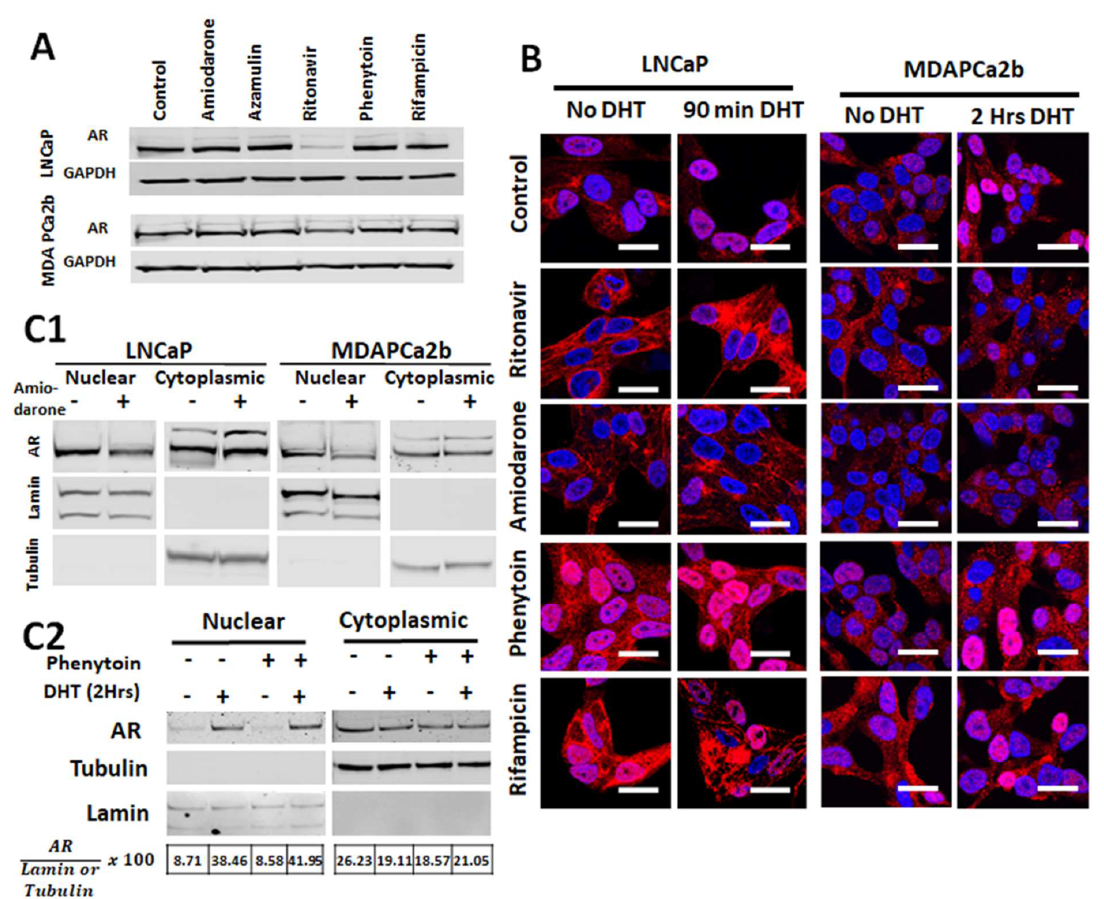
Figure 3. CYP3A5 inhibitors and inducers affect nuclear translocation of AR. ( A ) Effect of CYP inhibiting or inducing drugs on total AR expression. Total cell lysates from LNCaP and MDAPCa2b cells